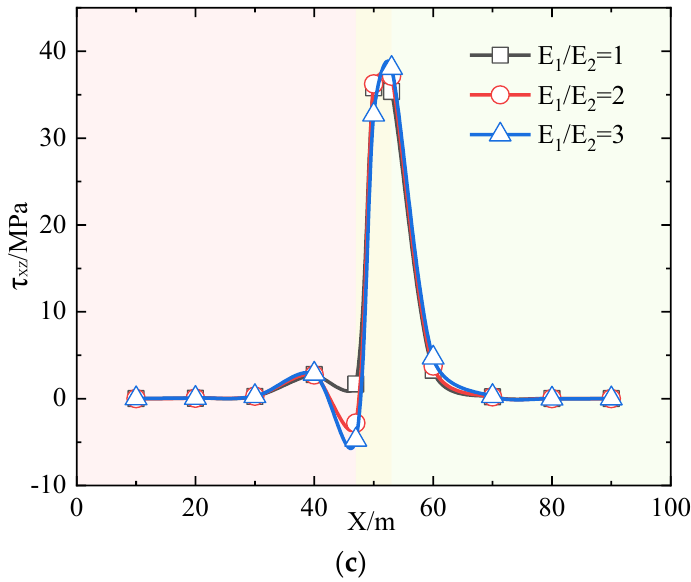
Figure 10. Analytical results for different values of E 1 / E 2 . ( a ) vertical stress, ( b ) horizontal stress, ( c ) shear stress.